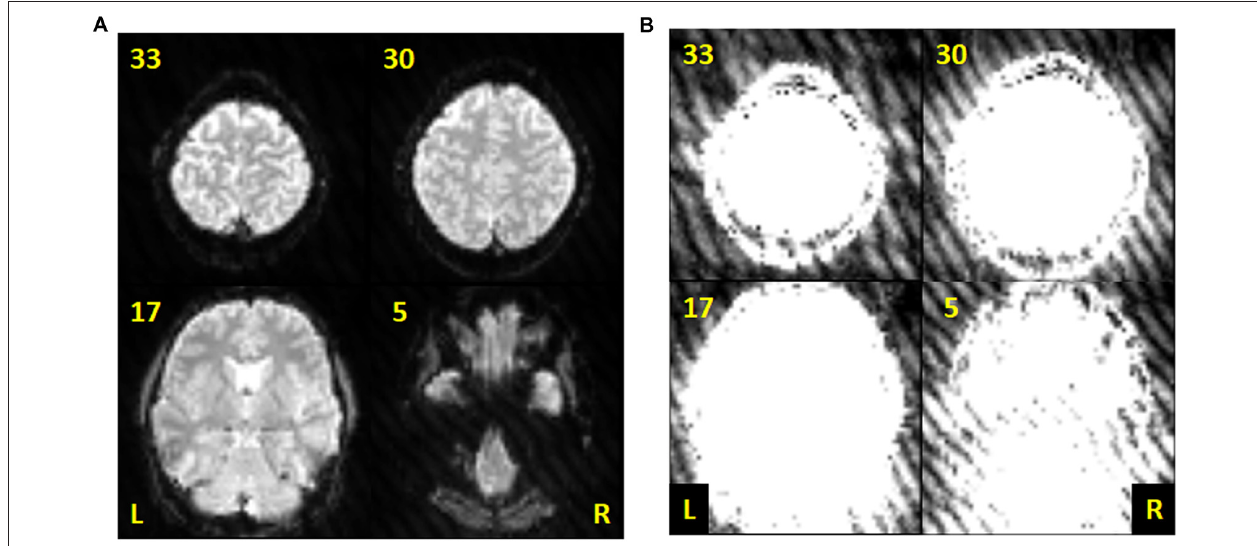
FIGURE 1 | Sample echo planar images from the resting state data of subject 001 (volume 60). (A) Slices 5, 17, 30 and 33 displayed using intensity values ranging from 10 to 1000. (B) Same slices as in (A) but displayed using intensity values ranging from 10 to 50 to highlight the gradient coil noise throughout the image.